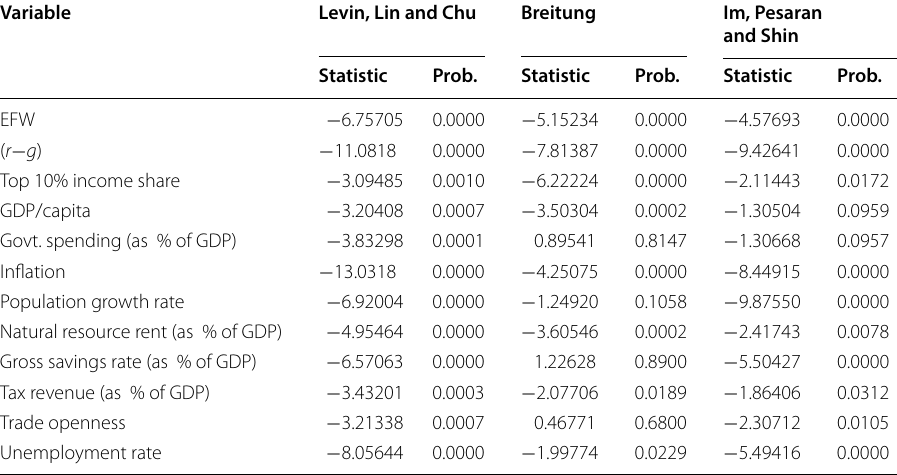
Table 2 Unit root result for global